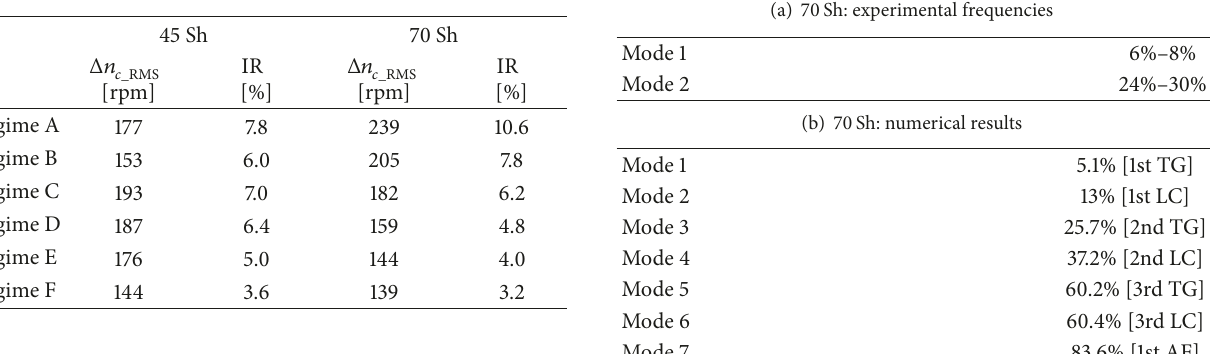
Table 3: Crankshaft velocity oscillations RMS value, Δ𝑛 𝑐 , and Irregularity Ratio, IR, computed for the stationary tests performed with the two highly flexible couplings.